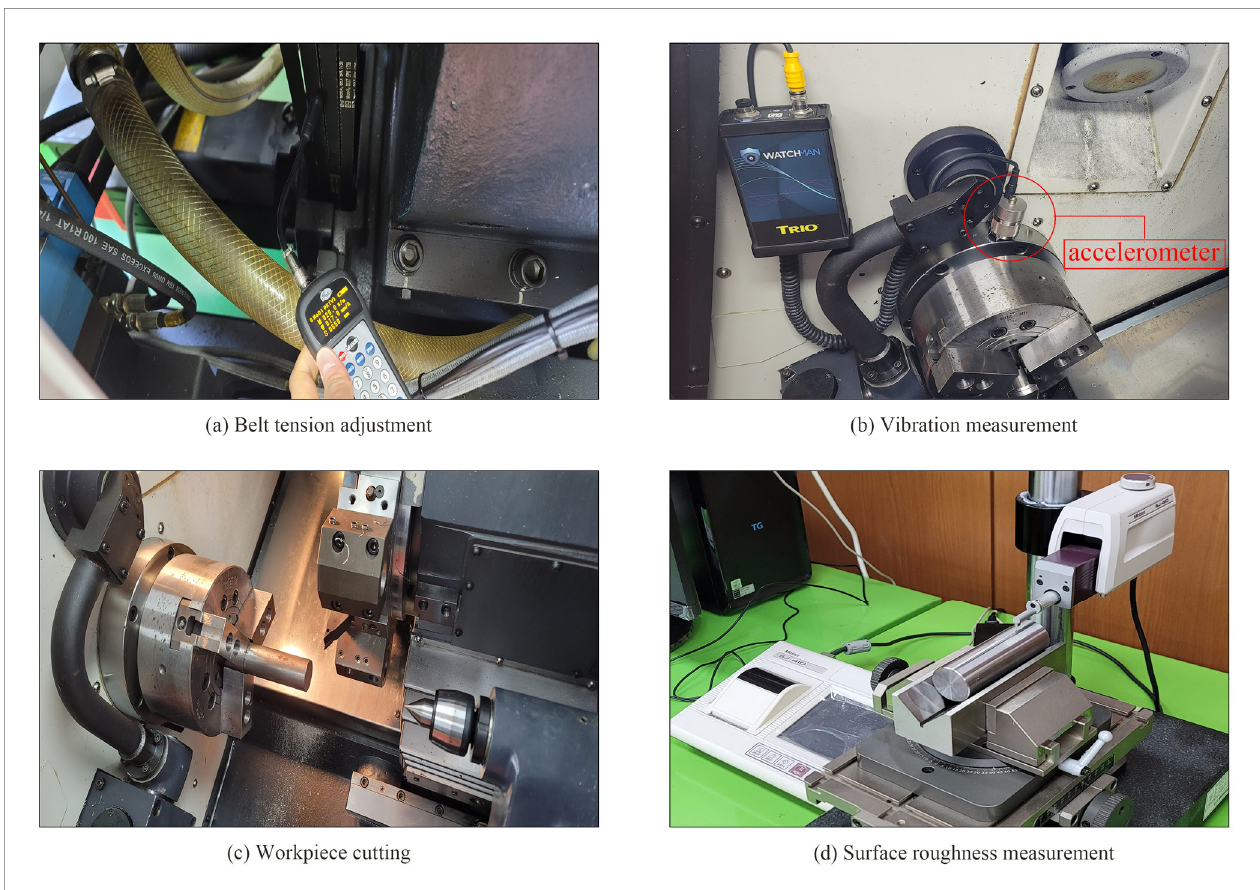
Figure 1. Schematic of the experimental procedure. ( a ) Tension adjustment of the belt that transmits power to the servomotor and spindle of the CNC lathe; ( b ) vibration measurement of the spindle inside the cutting room; ( c ) workpiece cutting according to conditions; ( d ) measurement of surface roughness after cutting.